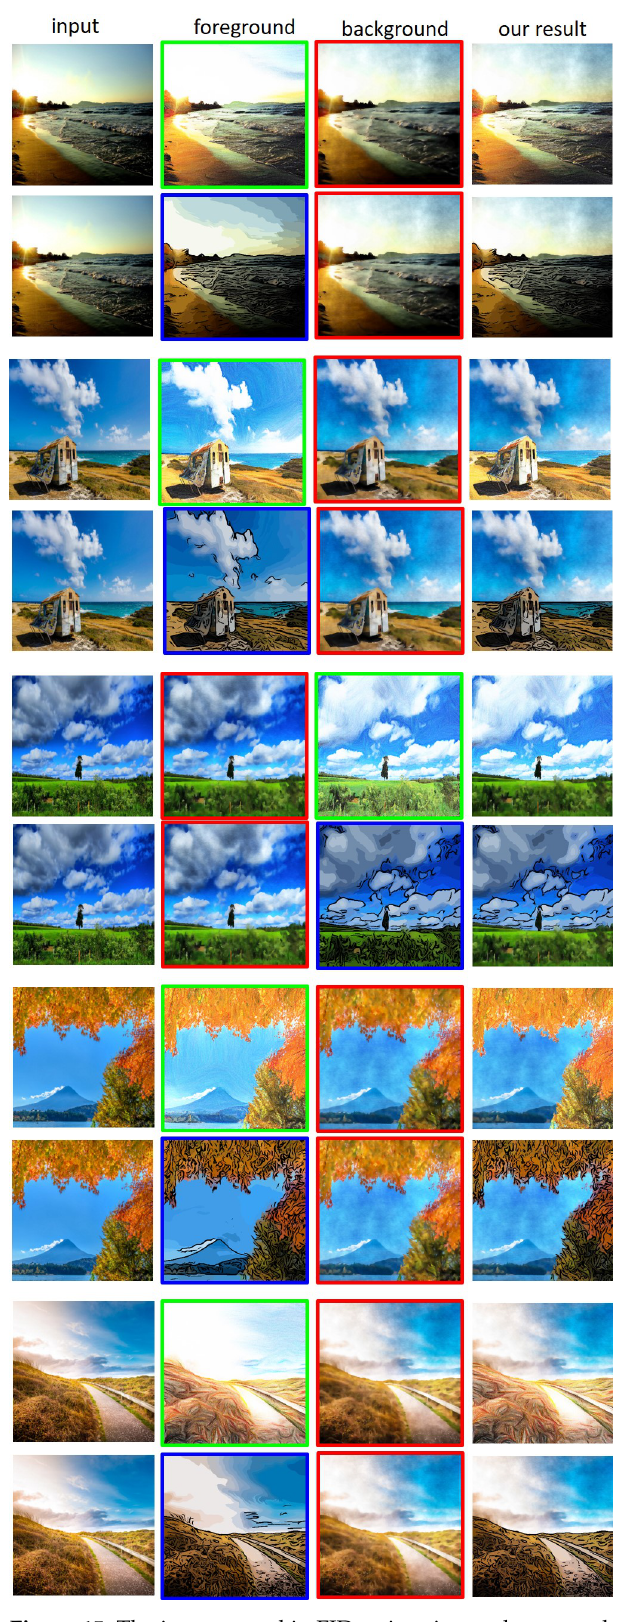
Figure 15. The images used in FID estimation and user study. Images in green box are rendered in pencil style, images in blue are in abstraction, and images in red are in